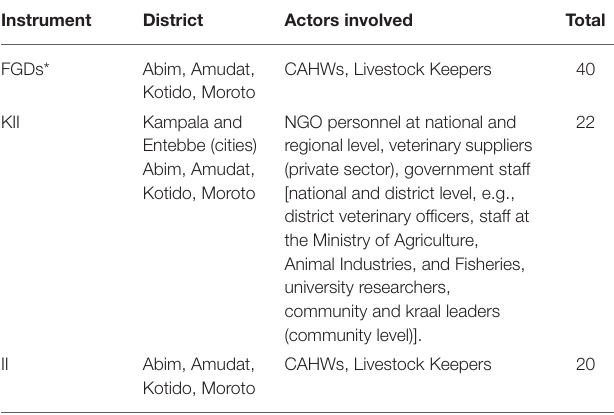
TABLE 1 | Data collection instruments.